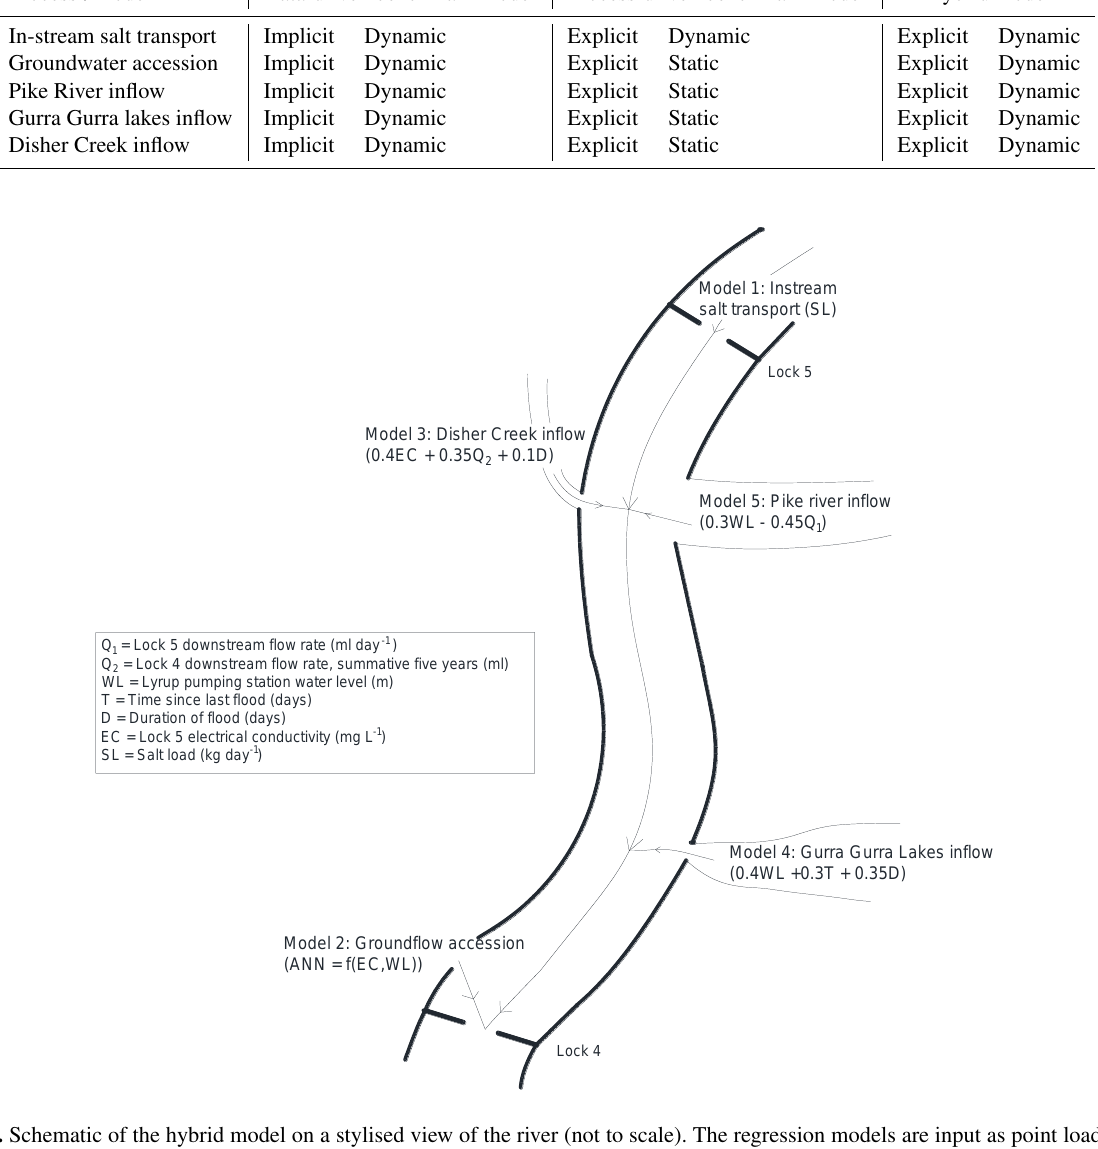
Figure 7. Schematic of the hybrid model on a stylised view of the river (not to scale). The regression models are input as point loads, while the groundwater accession is added to the transport model at Lock